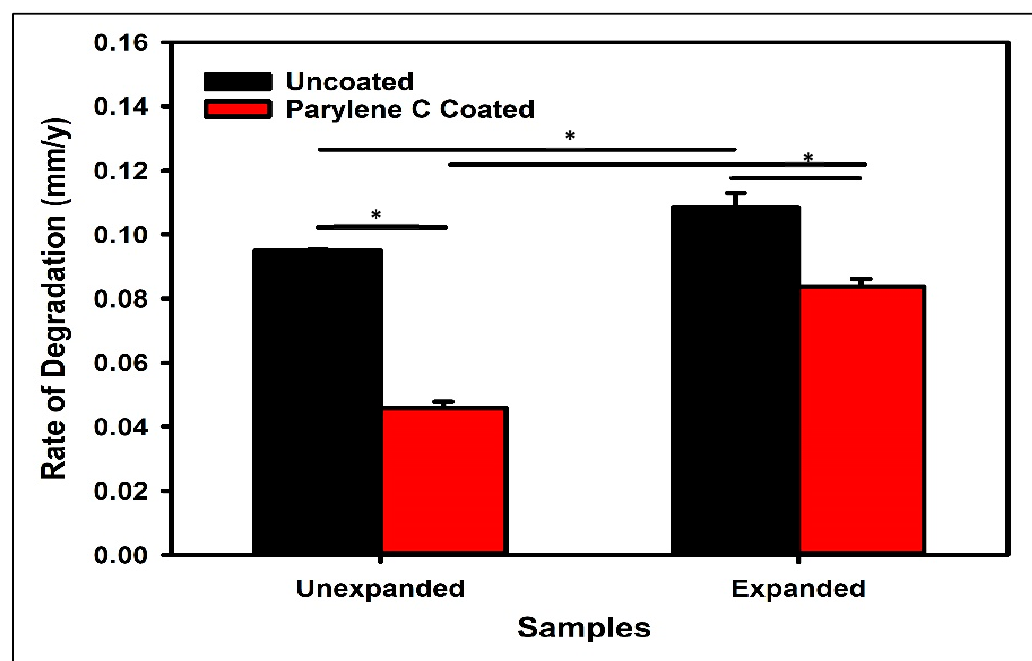
Figure 14. Comparison of corrosion rates between uncoated and Parylene C-coated Zn stent samples before and after expansion. (*) Significance level p = < 0.001.